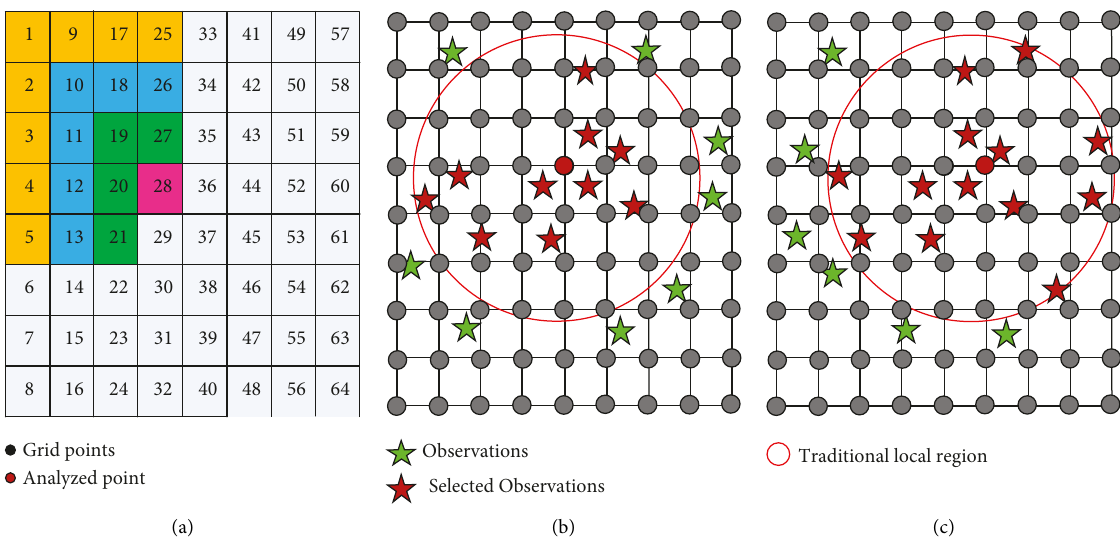
Figure 1: (a) shows the predecessors of the model component 28, the green region, blue region, and yellow region within the different localization radii. (b) and (c) show schematic diagrams of the observations used in the localization method from the i -th grid point to the ( i +1) th grid point. For each grid point (gray dots, the analyzed point is red). The localization region is drawn (red circle) and only those observation points (red pentacles) are included in the